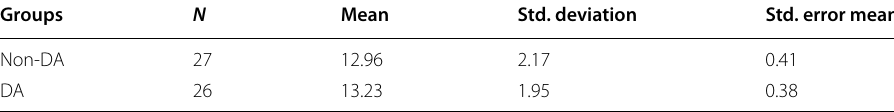
Table 1 Descriptive statistics (speaking pretest of both groups) Groups N